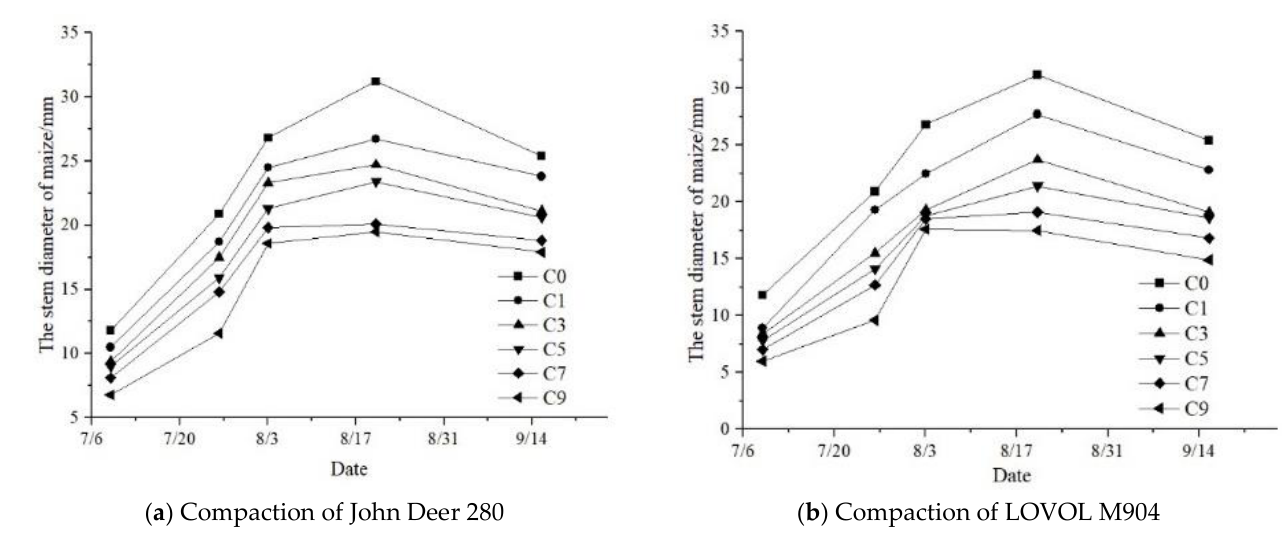
Figure 6. Change in maize stem diameter with time under different treatment conditions.